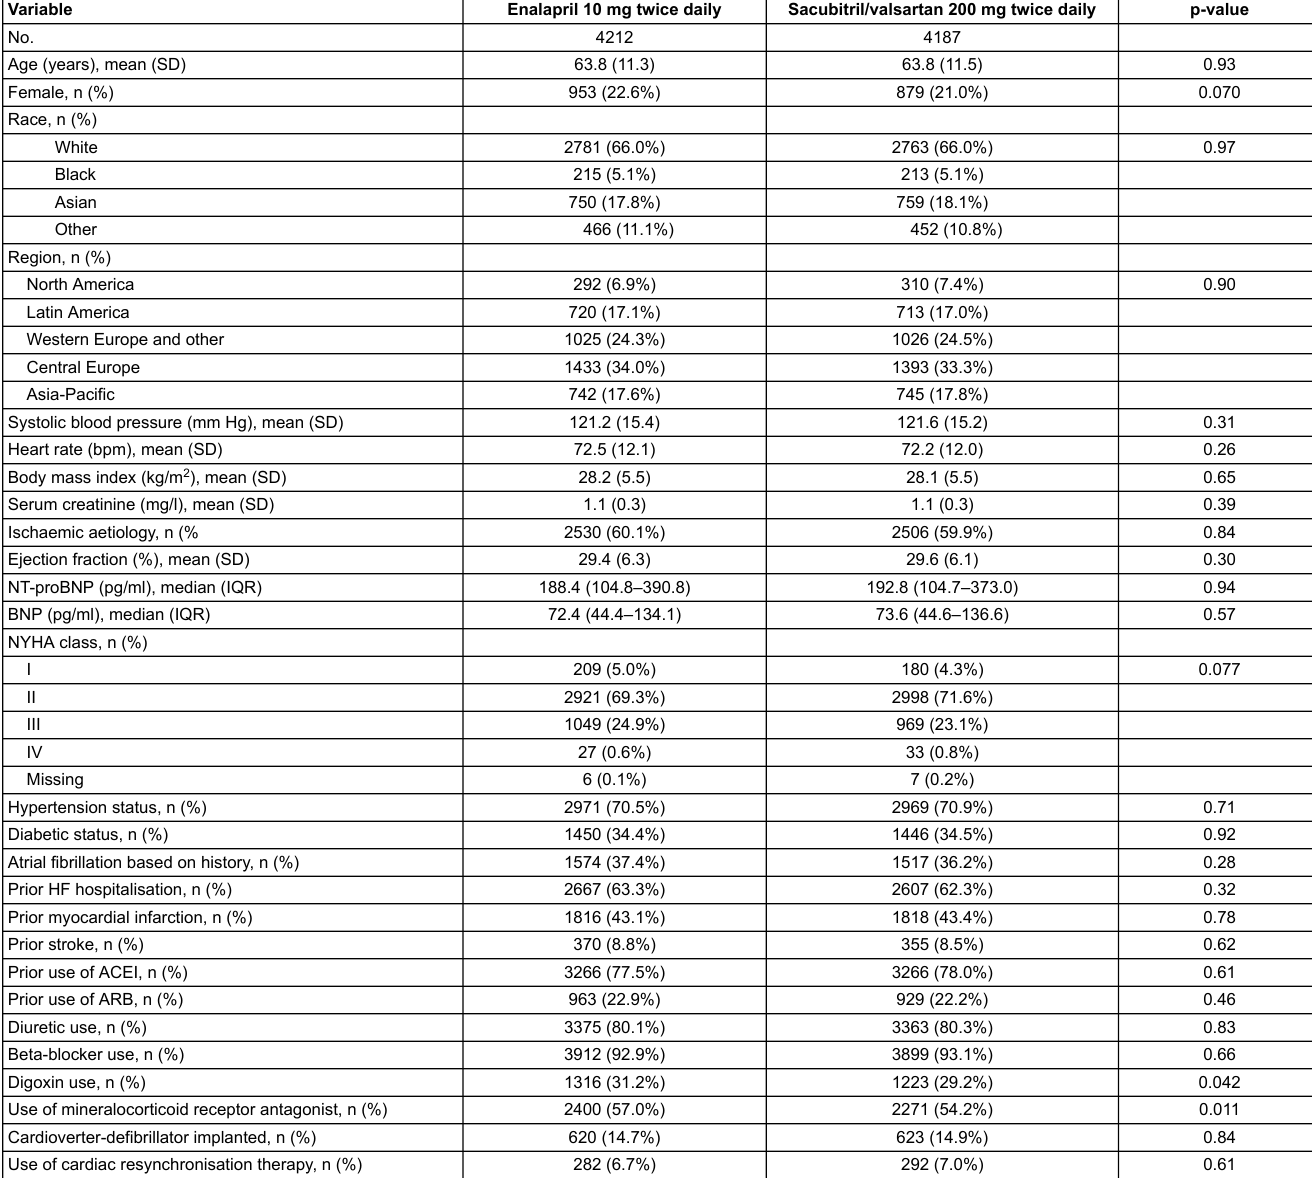
Table S1: Baseline characteristics of the PARADIGM-HF trial population (full analysis